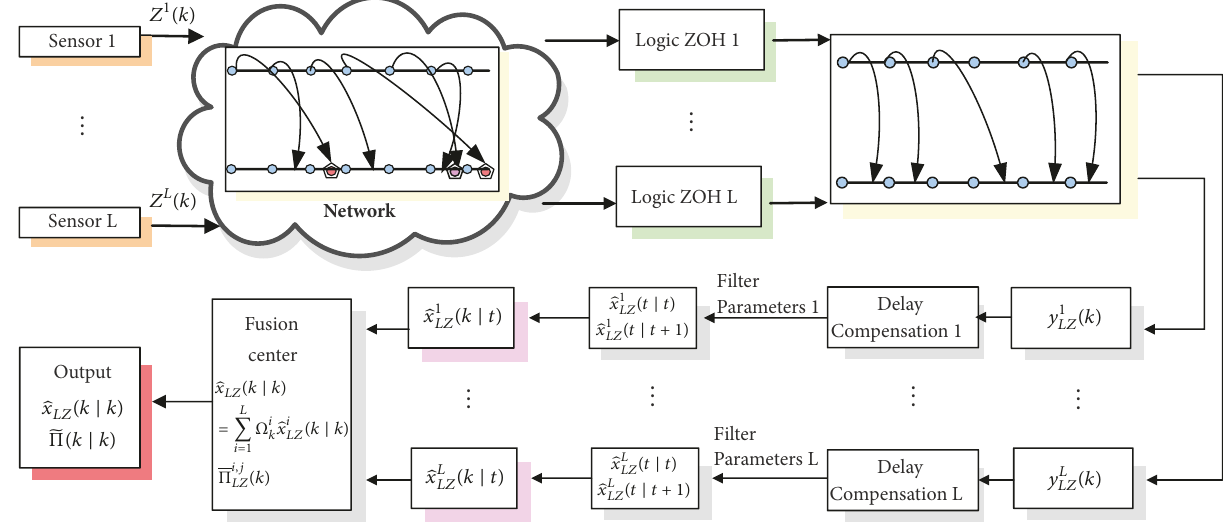
Figure 2: Computational procedure of distributed fusion estimation based on robust finite horizon filtering for logic